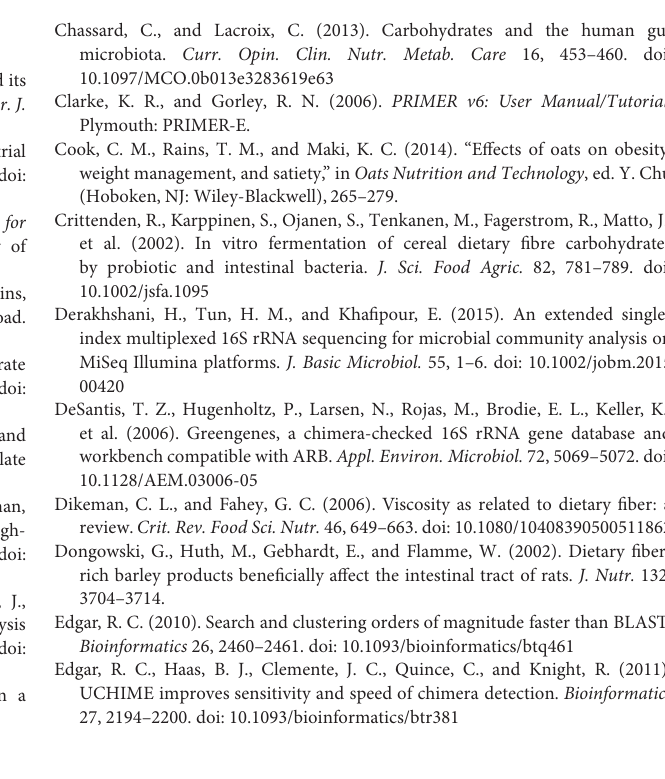
Figure S1 | Principal coordinate analysis (PCoA) of weighted UniFrac distances among all